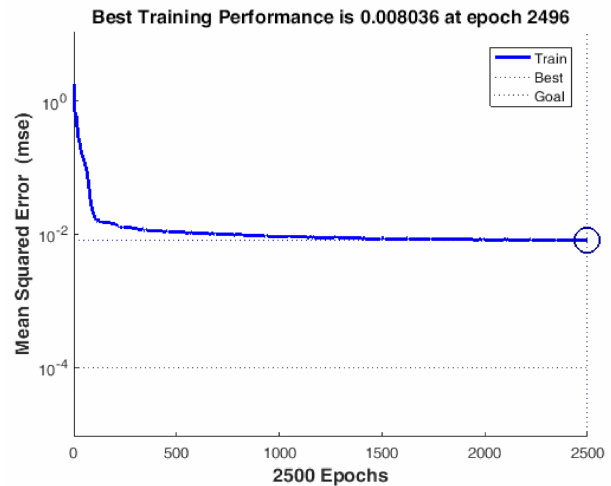
Figure 4. Variation between mean square error (MSE) and number of epochs of artificial neural network (ANN)